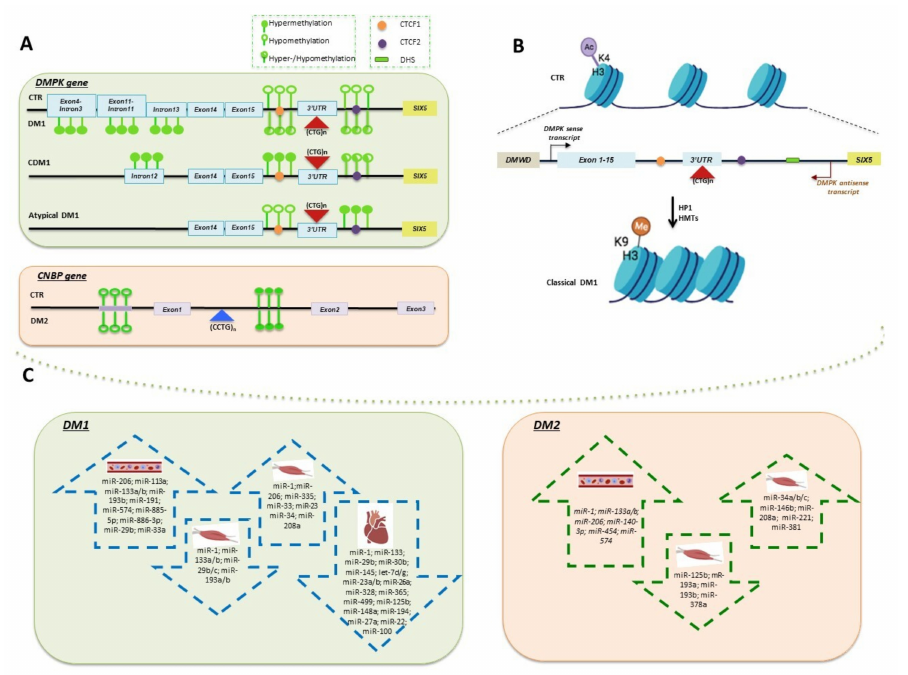
Figure 2. Epigenetic mechanisms in DMs pathogenesis. ( A ) Schematic representation of DNAme status in classical DM1, CDM1, atypical DM1, DM2 and CTR individuals. The two putative CTCF binding sites upstream (CTCF1) and downstream (CTCF2) of the CTG repeat at the DMPK locus are pictured as orange and violet circles, respectively. Empty green circles represent unmethylated CpG sites; filled green circles represent hypermethylated sites and the half-full green circles indicate both hyper- and hypo-methylated status. ( B ) Schematic drawing of chromatin remodeling of DM1 locus in CTR and classical DM1. Histone PTMs changes upon (CTG) n expansion reflect a less active chromatin environment. A schematic drawing of DM1 locus is also represented, indicating the expanded CTG array with flanking CTCF sites, the DNAse hypersensitive site (DHS) and the DMPK sense and antisense transcripts. ( C ) Most relevant deregulated miRNAs in skeletal muscle, heart and blood from DMs patients. Upregulated and downregulated miRNAs are included in blue and green dashed arrow-shaped boxes for DM1 and DM2 samples,